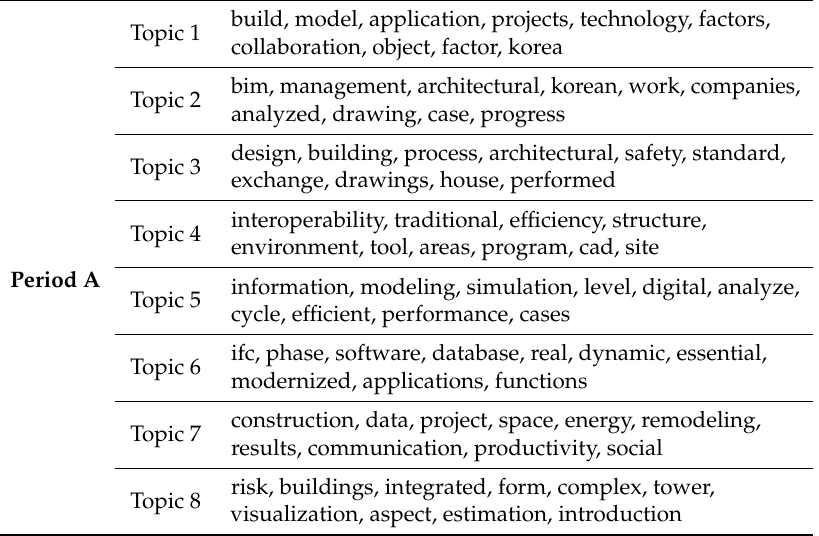
Table 5. Topic analysis results of Period A (Introduction).